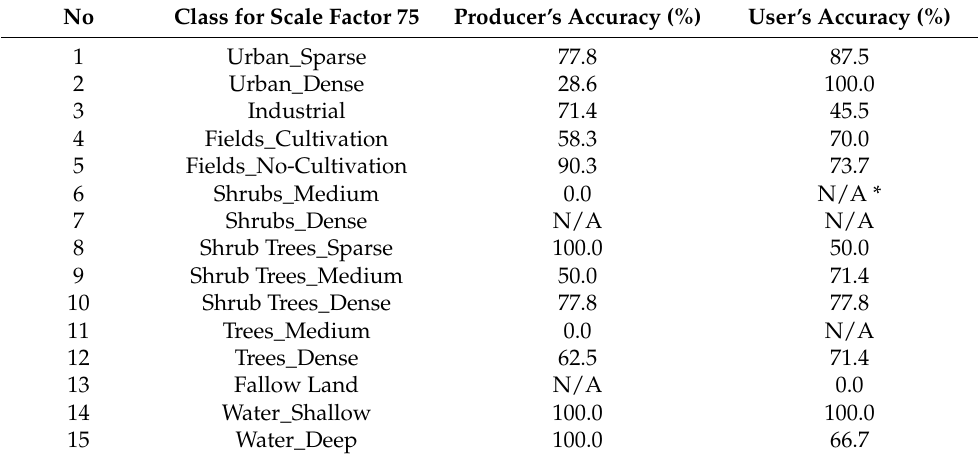
Table 3. The classification results of the Sentinel-2 subset of the 75-scale segmentation